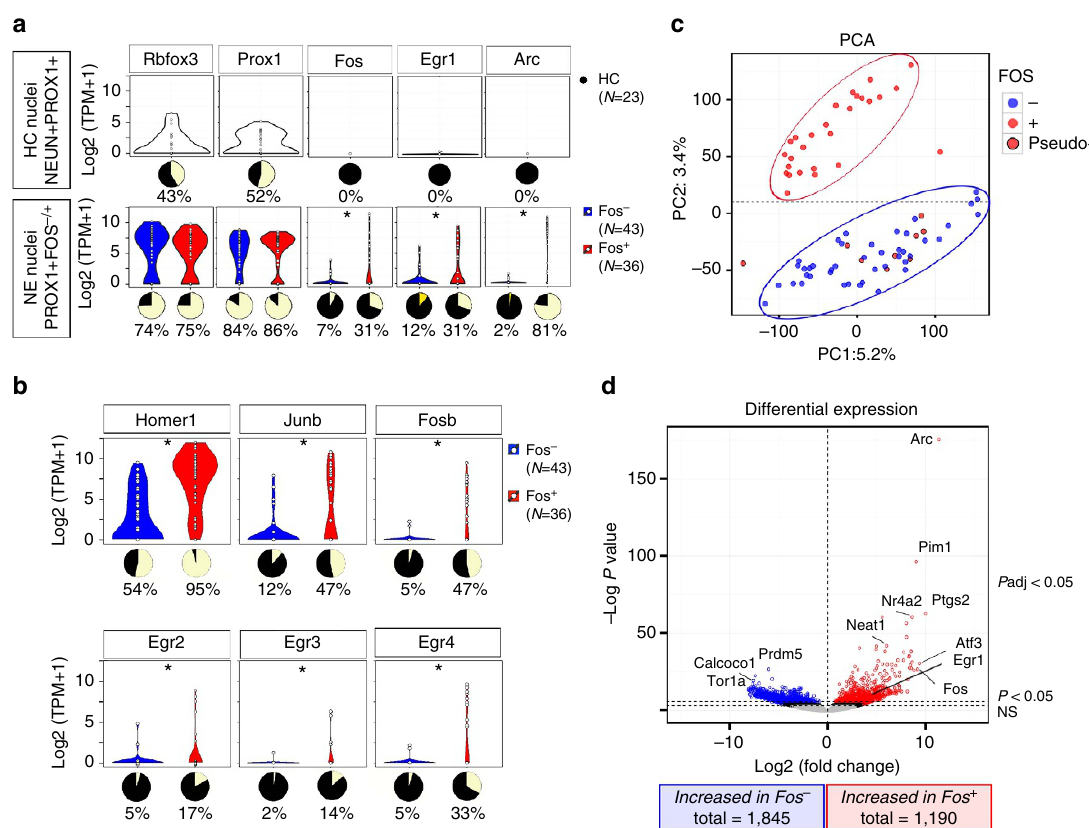
Figure 3 | IEG RNA expression in single DGC nuclei is associated with animal experience. ( a ) log2(TPM þ 1) Normalized RNA-seq values from HC NEUN þ PROX1 þ (top, n ¼ 23), NE PROX1 þ FOS (cid:2) (bottom, n ¼ 43), and NE PROX1 þ FOS þ (bottom, n ¼ 36) single-nuclei. NE FOS þ nuclei (red) exhibited higher levels of IEG expression than both NE FOS (cid:2) (blue) and HC nuclei (white). Stars indicate statistically significant differences in expression using edgeR after multiple-testing correction (fdrtool; R). Pie charts indicate the proportion of nuclei with detectable gene expression (yellow ¼ detected). ( b ) IEG expression in nuclei after exposure to NE. ( c ) Principal components analysis (PCA) of the full transcriptome for NE nuclei. pseudo-FOS þ cells in red with black outline. ( d ) Differential expression results for all genes between FOS þ and FOS (cid:2) nuclei excluding pseudo-FOS þ nuclei. Genes expressed to a higher level in FOS þ nuclei are in red and genes expressed higher in FOS (cid:2) nuclei are in